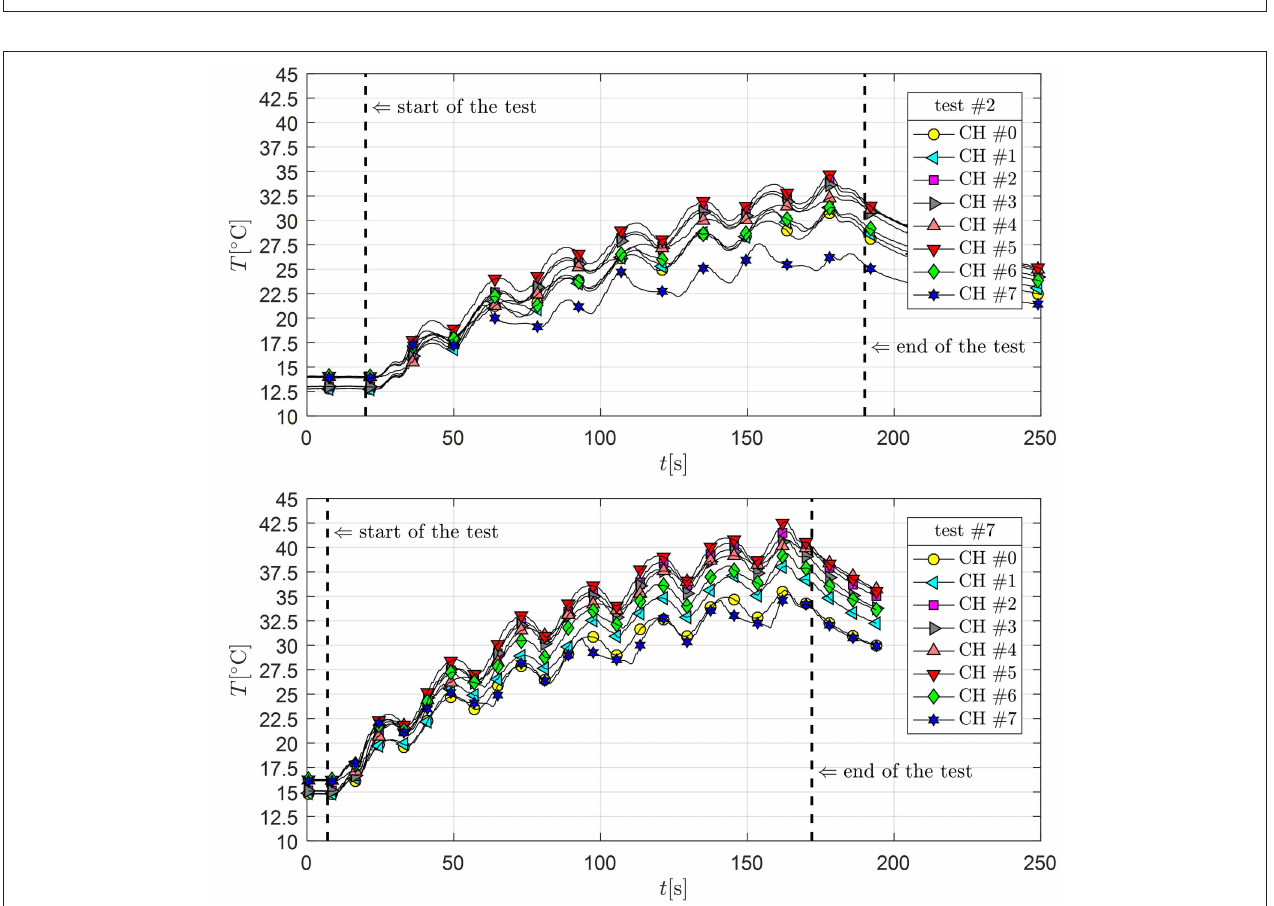
view of Figure 5 ) rather than along the x_test axis. Therefore, the thermocouple CH #6 is placed along the peripheral part of the slider perpendicular to the direction of the sliding motion, where the highest values of the contact pressure are expected to take